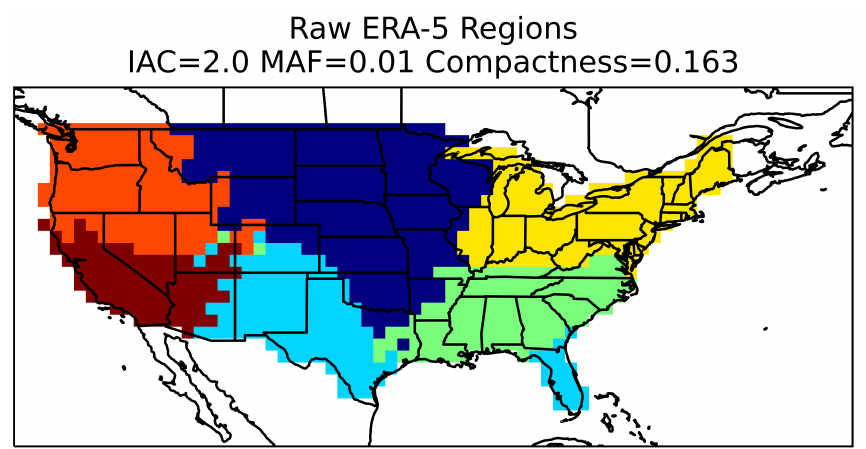
Figure 1. The raw output of the SOM trained on the normalized long-term daily mean of the cube root of precipitation at each grid point as in Swenson [29]. IAC and MAF refer to the map’s median isolated area count and minor area fraction, respectively.